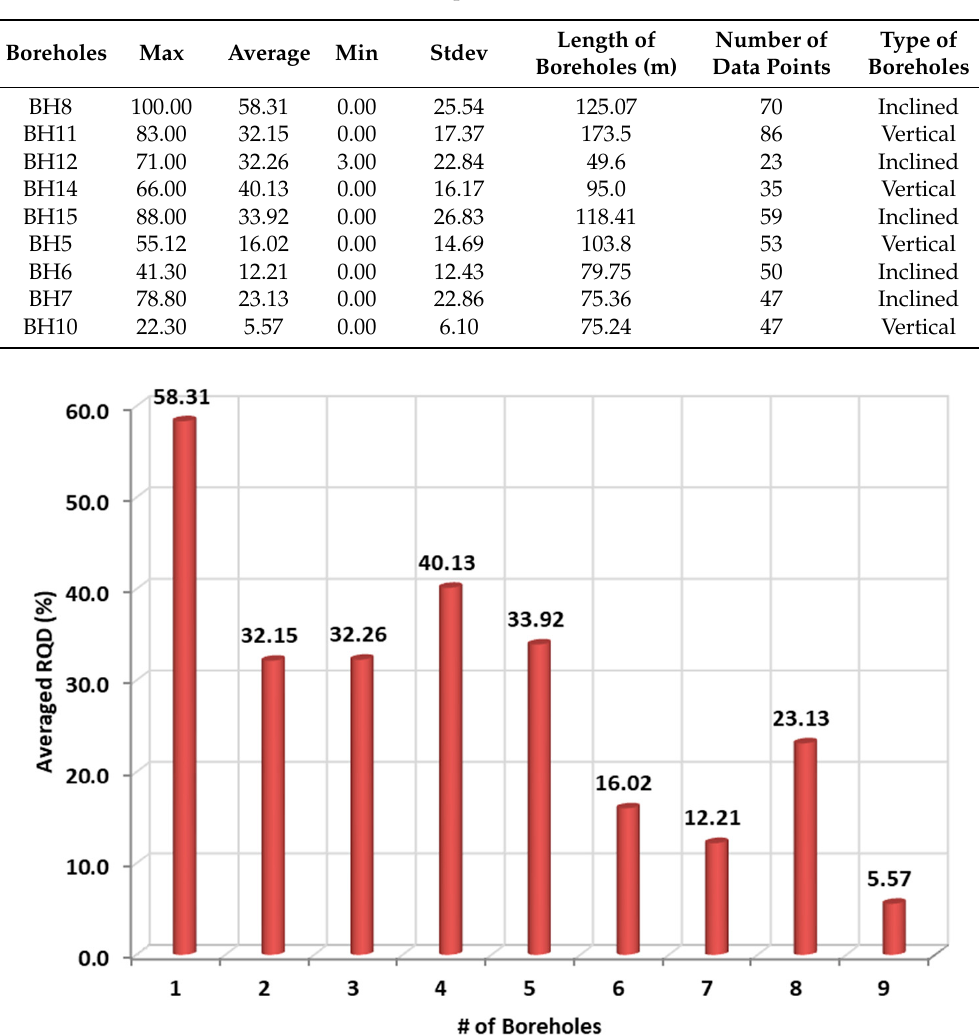
Figure 3. Average distribution of rock quality designation (RQD) for each borehole in the field. Table 1. Statistical description of RQD for each borehole.